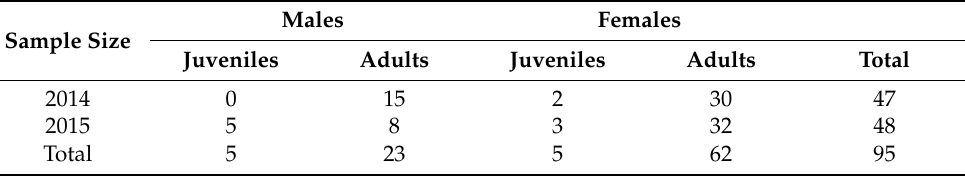
Table 1. Sample size per year, sex and age class for individual white-tailed deer harvested on Anticosti Island (Quebec, Canada) in 2014 and 2015 and retained in the statistical analyses of mushroom species